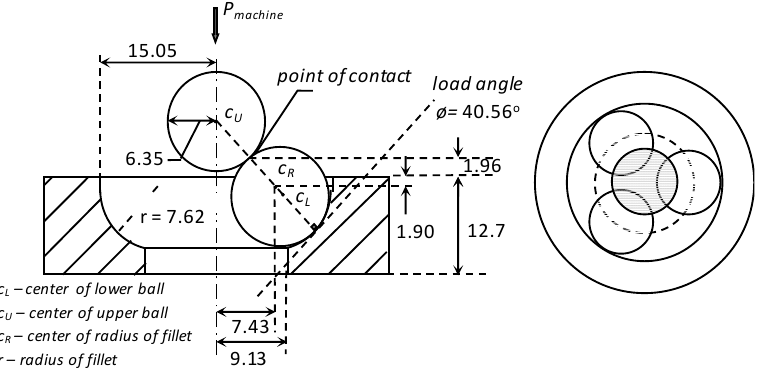
Table 2. Ball specifications.